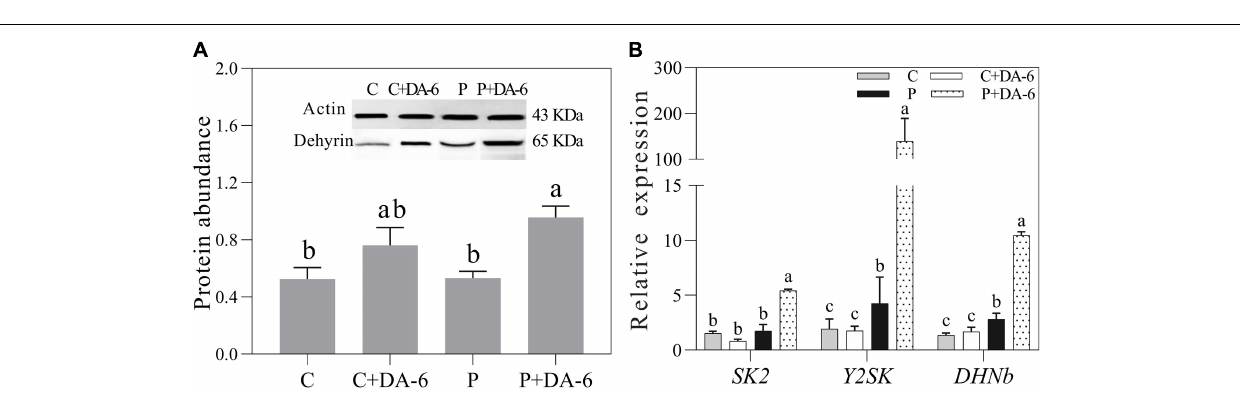
FIGURE 8 | Effect of seed priming with distilled water or DA-6 (2 mM) on (A) Dehydrins abundance, and (B) SK2 gene , Y2SK gene, and DHNb gene expression level after 3 days of germination in white clover under well-watered condition and drought stress. Different letters above different treatments represent significant difference ( p ≤ 0.05). Vertical bars show the ± SE of mean ( n =